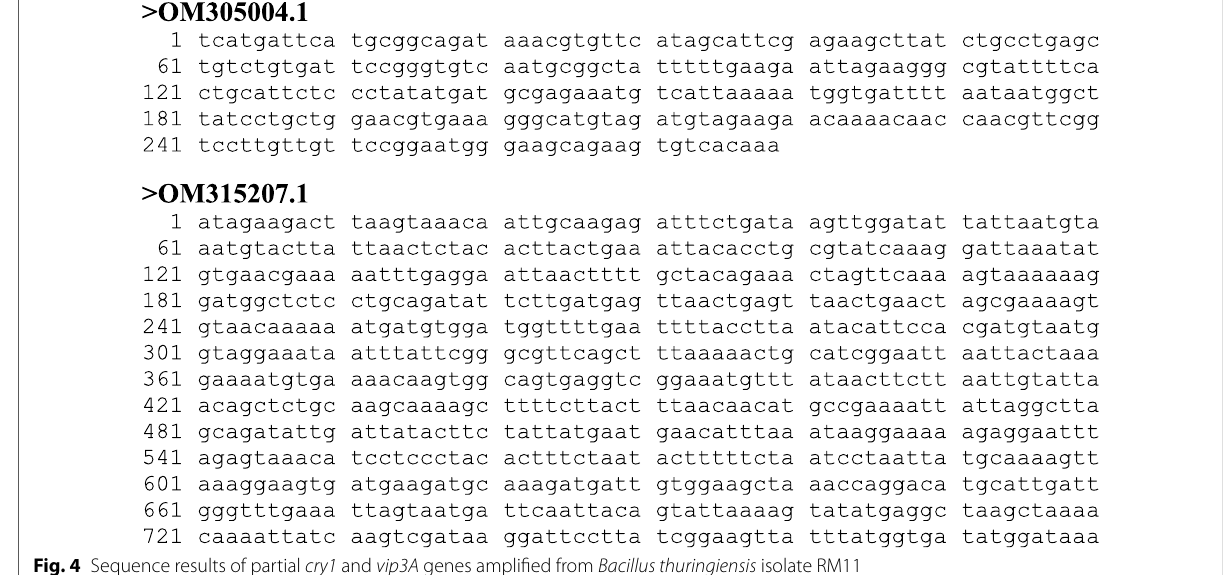
Percent identity: 100%